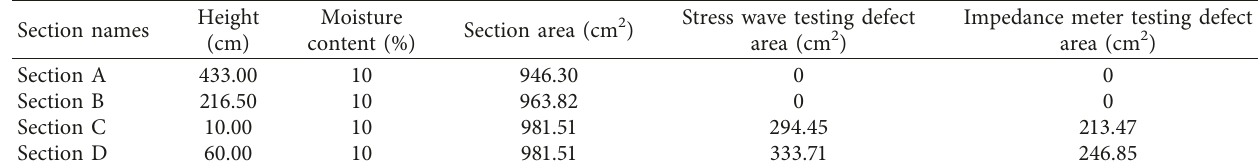
Figure 5: Stress wave analysis of pillar B2 showing (a) different sections of the pillar and (b) a longitudinal sectional of the internal defects. Table 1: Nondestructive testing data of pillar